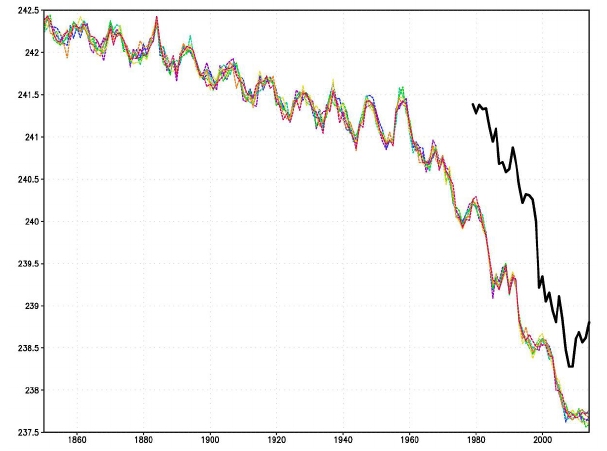
Figure 8. Annual mean global mean temperature (K) at 5hPa for ERA-Interim data (black) and model data (dashed color lines).